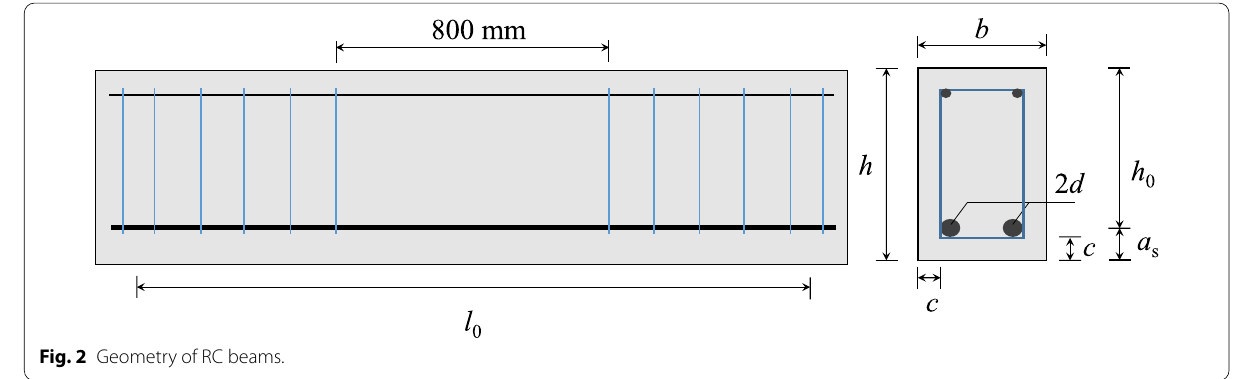
Fig. 2 Geometry of RC beams.